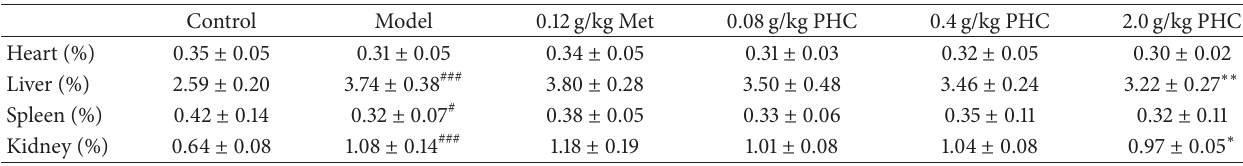
Data are expressed as mean ± SD ( 𝑛 = 10 ) and analyzed by using one-way ANOVA. # 𝑃 < 0.05 and ### 𝑃 < 0.001 versus normal controls, ∗ 𝑃 < 0.05 and ∗∗ 𝑃 < 0.01 versus model